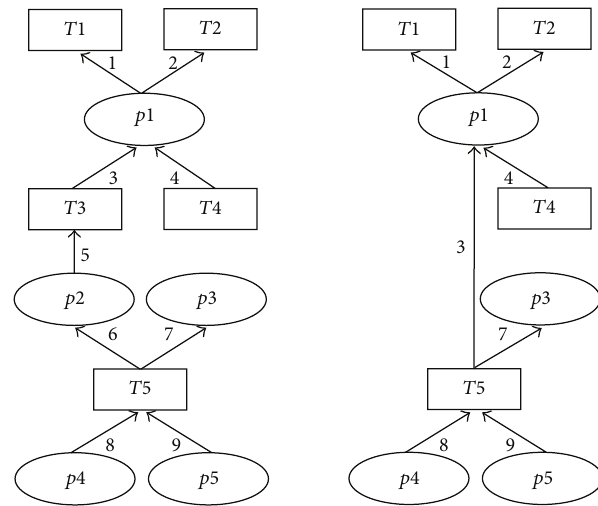
Figure 3: Effect of the reduction algorithm.